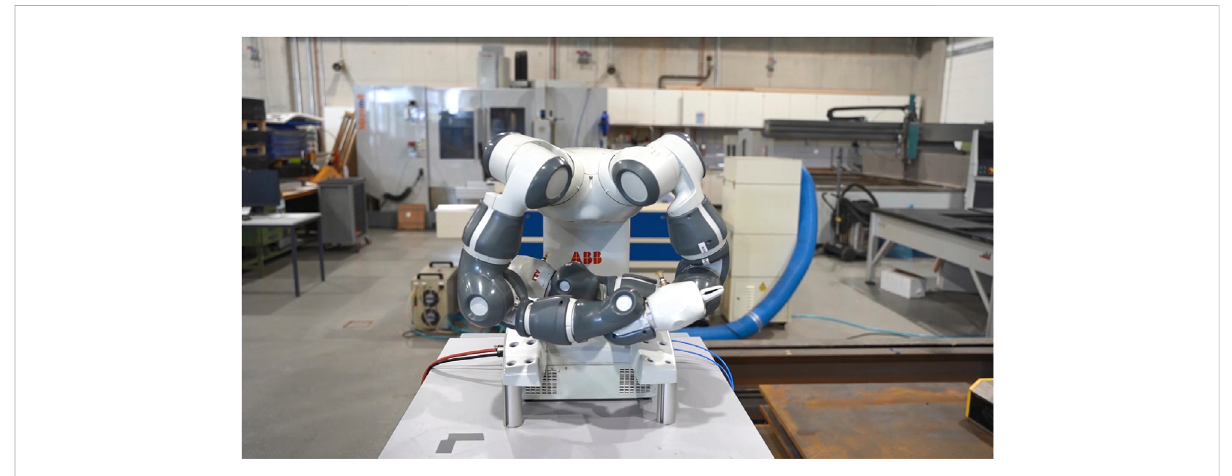
FIGURE 3 The large arm spread presented by the Yumi IRB 14000 dual-arm